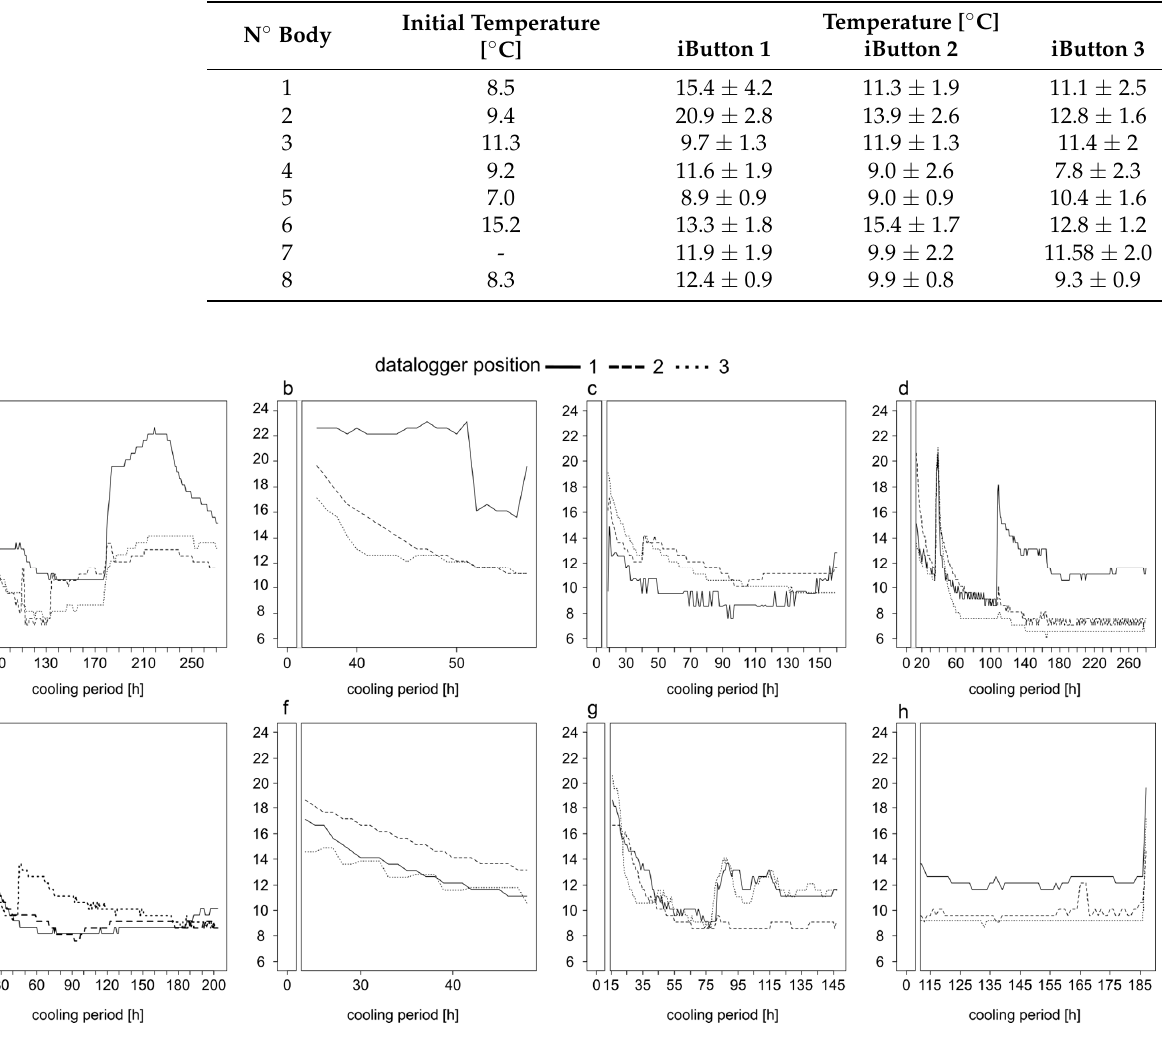
Figure 2. Temperature differences between the maggot masses on bodies stored in a walk-in cooler. Information on the period of temperature measurement and the entire cooling period are given in Table 1. The temperature profiles belong to corpse 1 ( a ), corpse 2 ( b ), corpse 3 ( c ), corpse 4 ( d ), corpse 5 ( e ), corpse 6 ( f ), corpse 7 ( g ), and corpse 8 ( h ). The asterisks representing p -values with *** < 0.001, ** < 0.01, * < 0.05, n.s not significant.